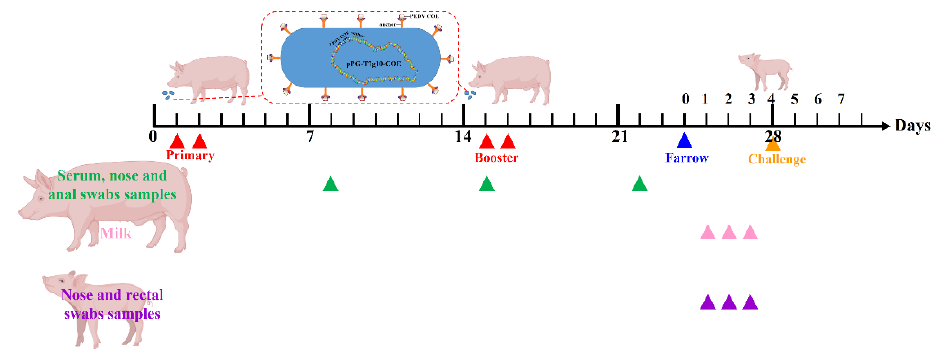
Figure 1. Immunization protocol and sampling